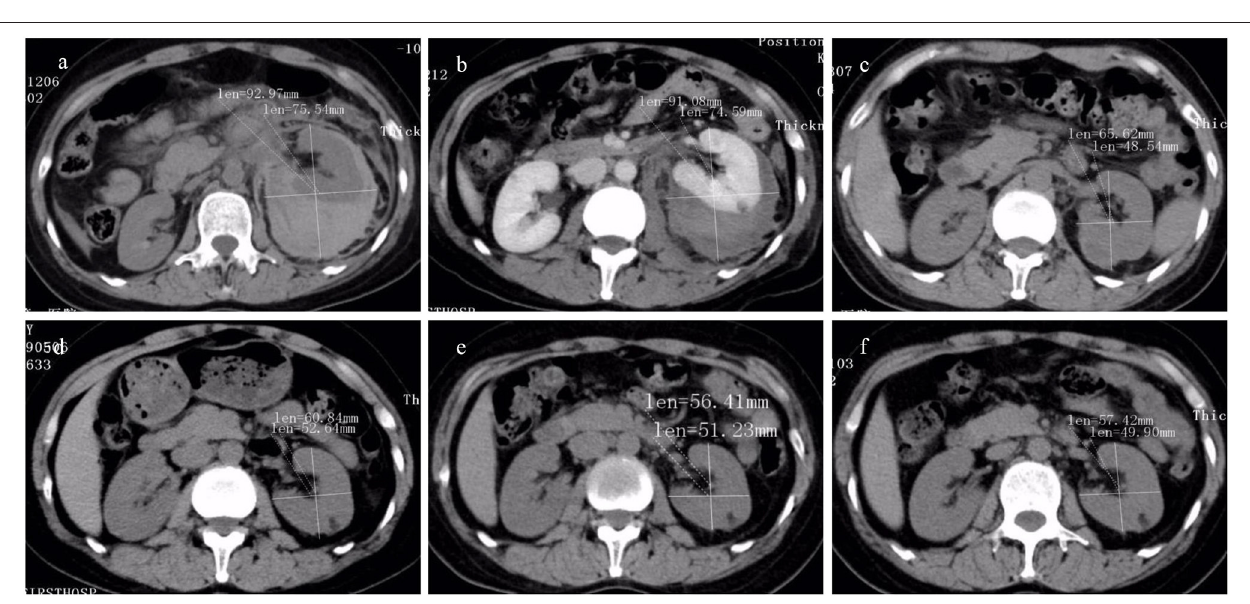
FIGURE 5 | The CT findings of renal hemorrhage size owing to Wunderlich syndrome (WS) pre- and post-transcatheter arterial embolization (TAE) (the same patient as in Figure 2 ) were listed. High-attenuating hemorrhagic areas were seen around the kidney. (a–f) CT image obtained at pre-TAE, and at follow-up period of 1 week, 1 month, 3 months, 6 months, and 12 months. A significant reduction in hemorrhage size was